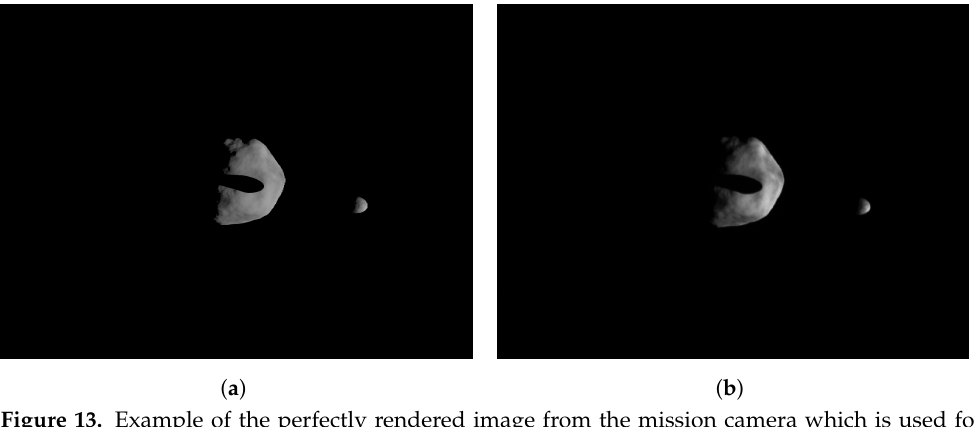
Figure 13. Example of the perfectly rendered image from the mission camera which is used for preliminary design and of the facility image mapped to the mission camera that includes HIL effects. The images show the asteroid binary system Didymos as seen from the Milani CubeSat’s camera (see Piccolo et al. [31] for further details). ( a ) Perfectly rendered image from the mission camera in the virtual world. ( b ) Facility image mapped to the mission